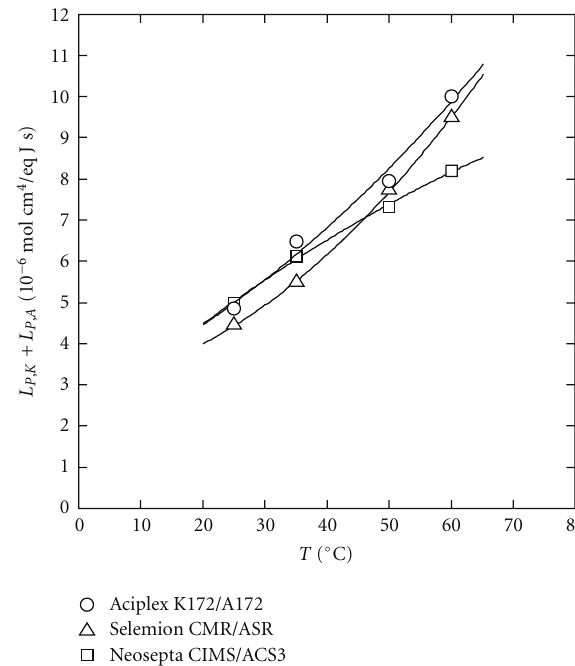
Figure 6: Relationship between temperature and solute permeabil- ity.